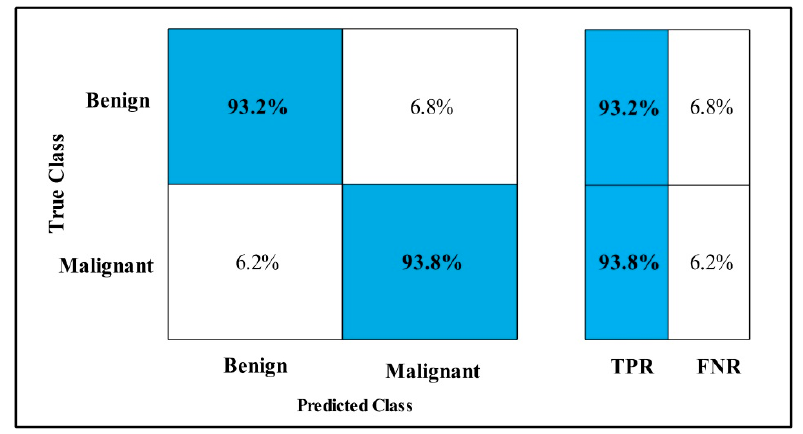
Figure 10. MEWOA TPR on Nasnet Mobile CBIS-DDSM. In Table 6, by using CBIS-DDSM dataset, Serial Fusion on MobilenetV2 and Nasnet deep features is applied. The GAP layer extracts deep features from the dataset and feeds them to classifiers. Table 6. Classification results using Fusion on MobilenetV2 and Nasnet deep features for CBIS-DDSM.